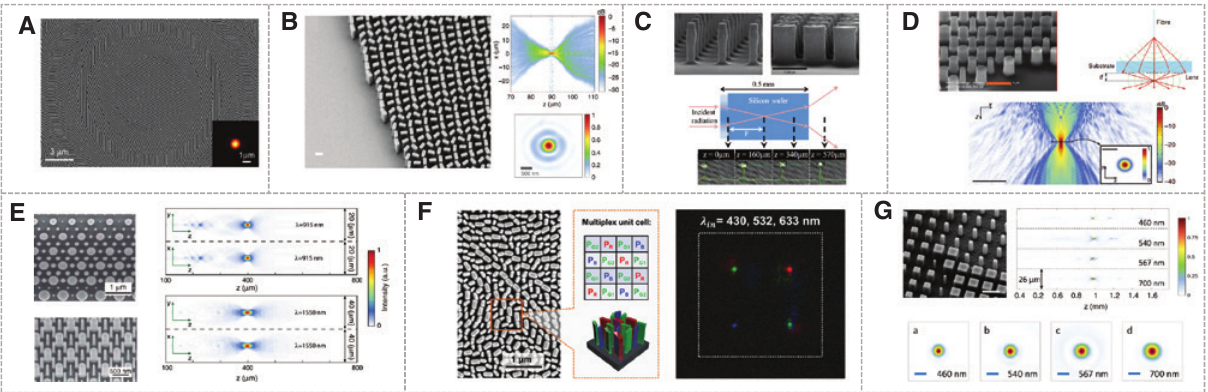
Figure 6: (A–D) Early proposed dielectric metalenses [30, 31, 65, 116]. (A) Dielectric gradient optical elements [31]. High-index dielectric gratings using the PB phase are arranged to achieve the lens phase profile. The inset shows the intensity profile at focus. (B) Visible wavelength metalens for diffraction-limited focusing and subwavelength resolution imaging [30]. The left image shows the SEM captured TiO metalens. The right two images are the measured intensity profile 2 near the focal points. The upper images are captured at the plane that contains the propagation direction vector and the lower plane is perpendicular to the propagation direction. (C) All-dielectric subwavelength focusing lens [116]. The upper images are SEM images from the fabricated sample. The lower images are showing the schematics and the measured intensity profiles of various positions. (D) Subwavelength-thick lenses with high numerical apertures and large efficiency based on high-contrast transmitarray [65]. The upper left image shows the tilted SEM image of transmitarray. The right images show the schematics of the proposed transmitarray. The lower image shows the intensity profile of the proposed structure. (E-G) Metalenses for multiwavelength operation [72, 76, 77]. (E) Multiwavelength polarization-insensitive lenses based on dielectric metasurfaces with metamolecules [77]. The left two images are the top view and the tilted view of the metasurfaces captured by SEM. Right intensity profiles are described as simulation (top) and experimental results (bottom) and detached by wavelengths. (F) Gallium nitride metalens for color routing [76]. The left images describe how the building blocks are made of, and the SEM images are shown as well. The right figure shows the experimental result of which the focal points are distinct in transverse direction. (G) Titanium dioxide metasurface for multiwavelength functions [72]. The upper left image is the tilted view of the fabricated sample. The remnant images show the measurement result of the multiwavelength